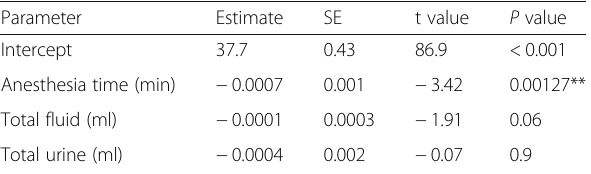
Table 3 Result of multiple regression of body temperature